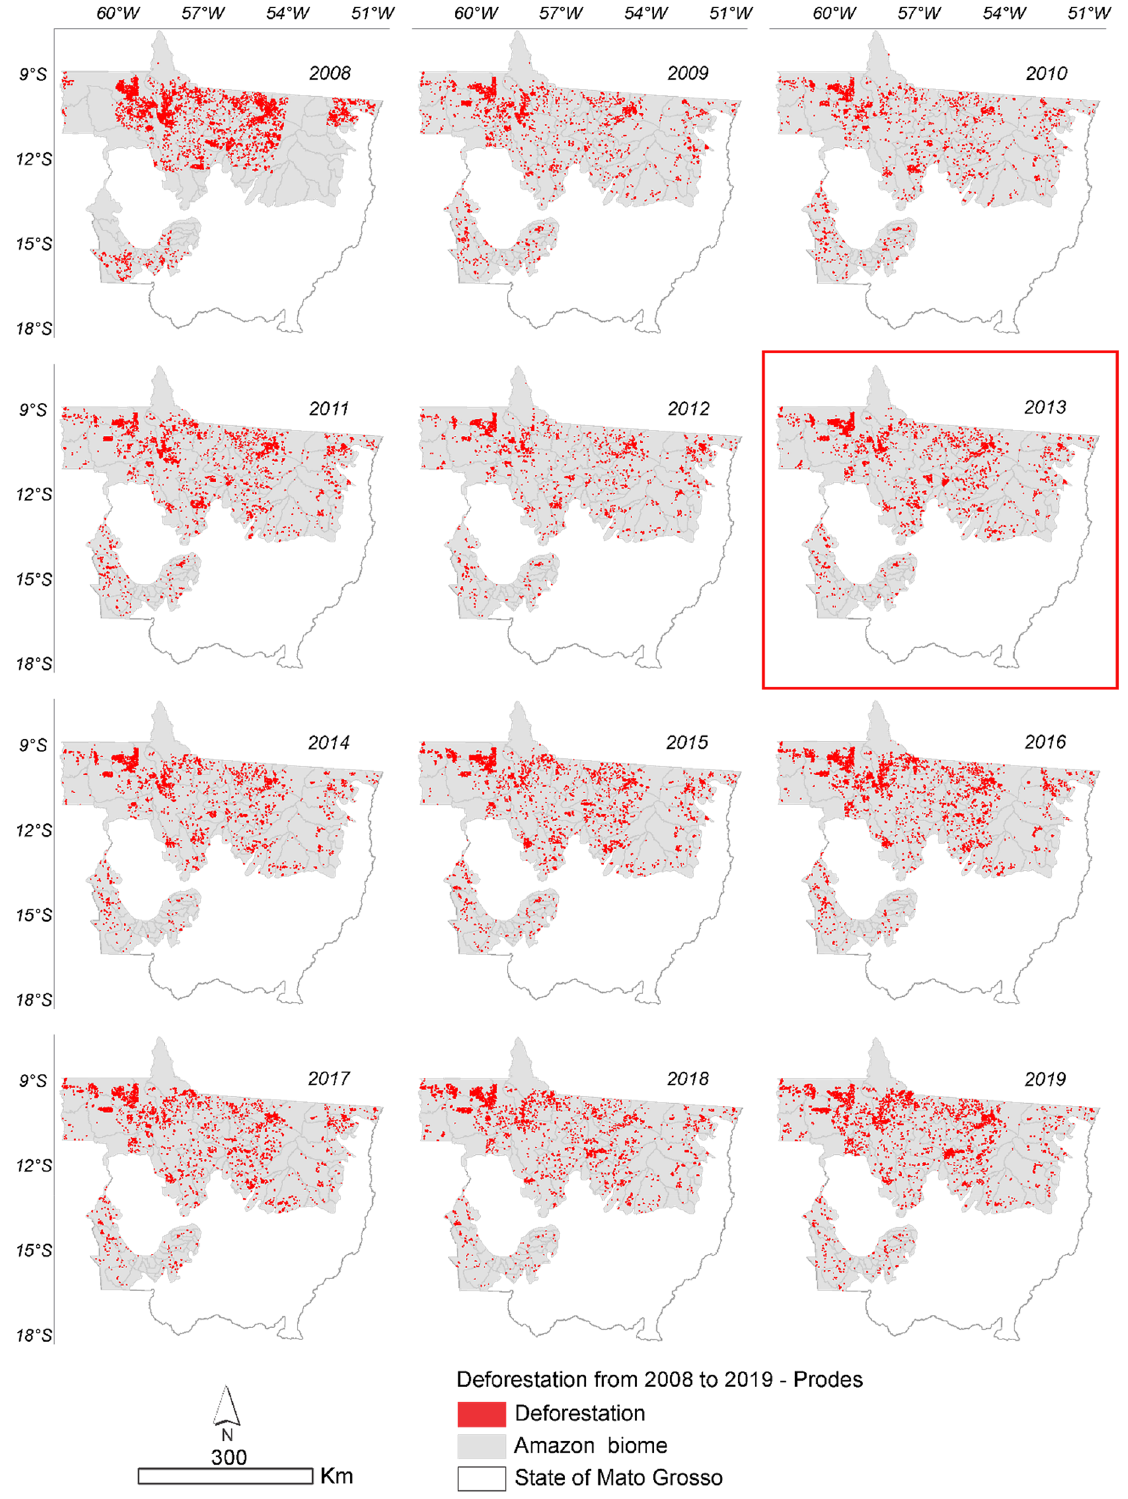
Figure 1. Annual deforestation in the Amazonia biome in the State of Mato Grosso from August 2008 to October 2019 with PRODES data. The highlighted year corresponds to the point of change in the time series through Pettitt test (Table